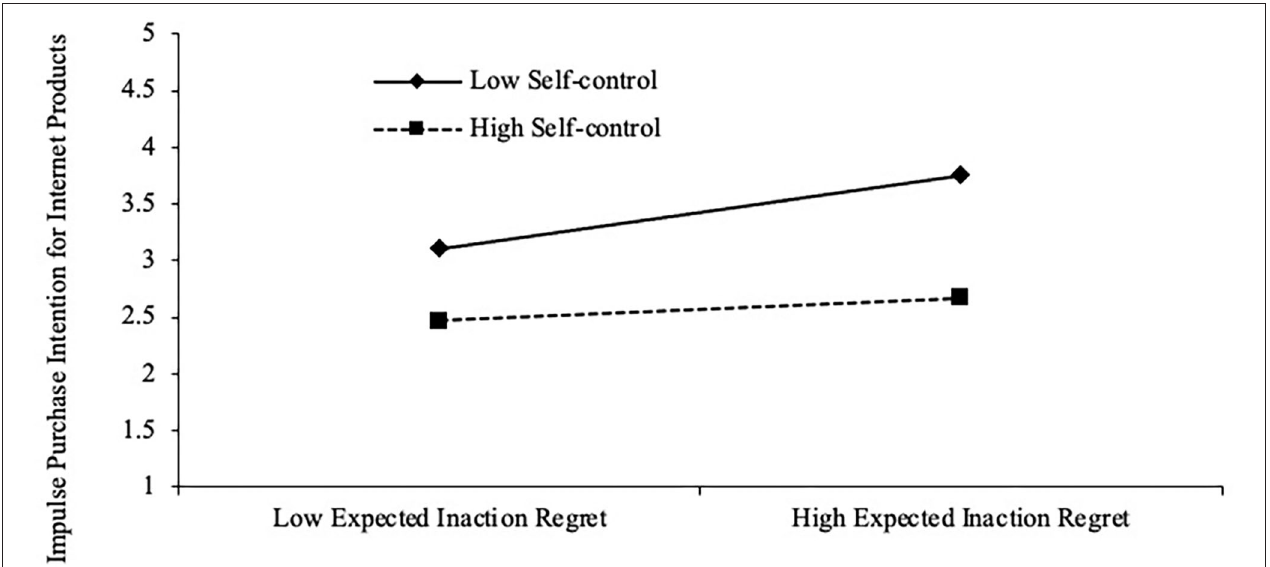
FIGURE 2 | The regulating effect of